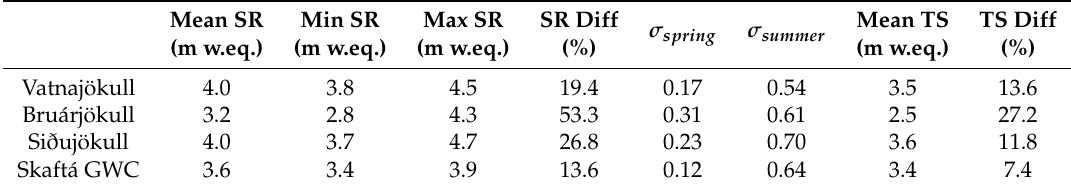
Table 3. The mean runoff of all the sensitivity runs (SR), the mean runoff when the maximum and minimum runoff is chosen for the whole time series and the percentage increase in runoff between the maximum and the minimum. σ spring is the mean standard deviation in runoff when the spring conditions are varied and σ summer is the mean standard deviation in runoff when the summer weather is varied. The mean runoff of the thick snow (TS) run, and the difference in runoff between the original simulation and the thick snow simulation are also given. Mean